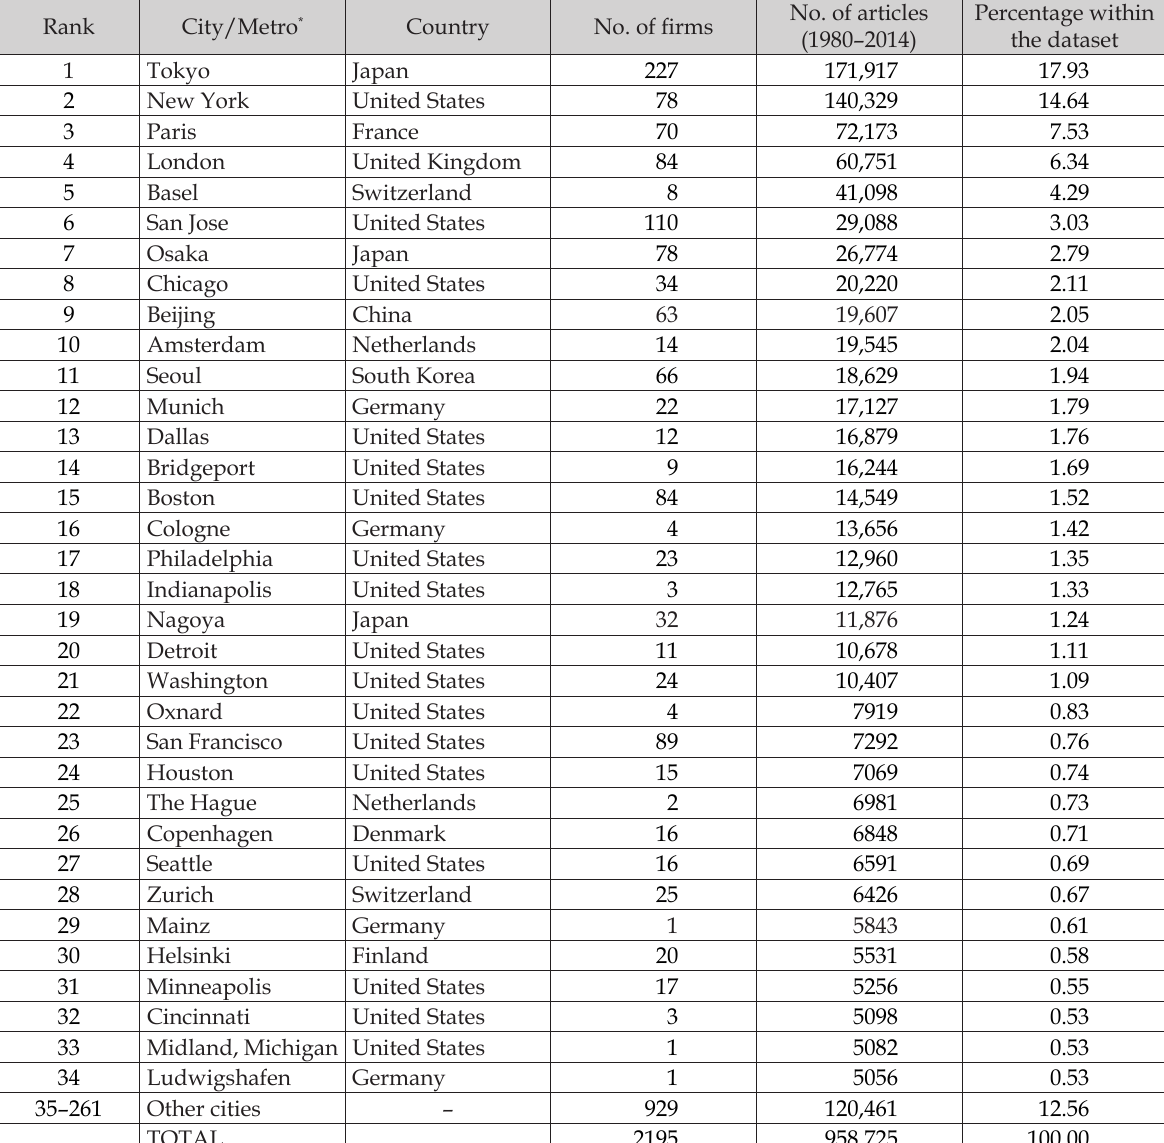
Table 3. Ranking cities by the total number of scientific articles published by headquartered firms. Rank City/Metro